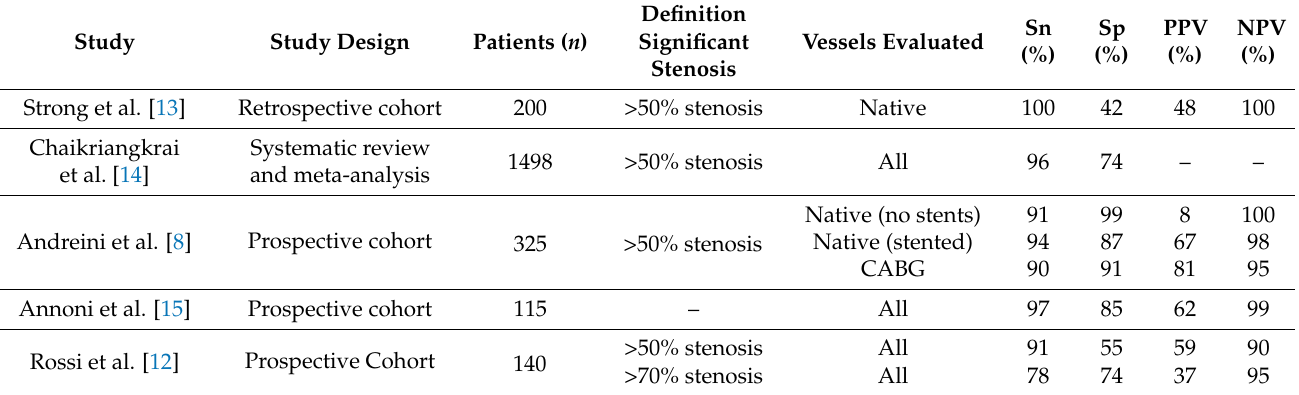
Table 1. The role of CTCA in TAVI